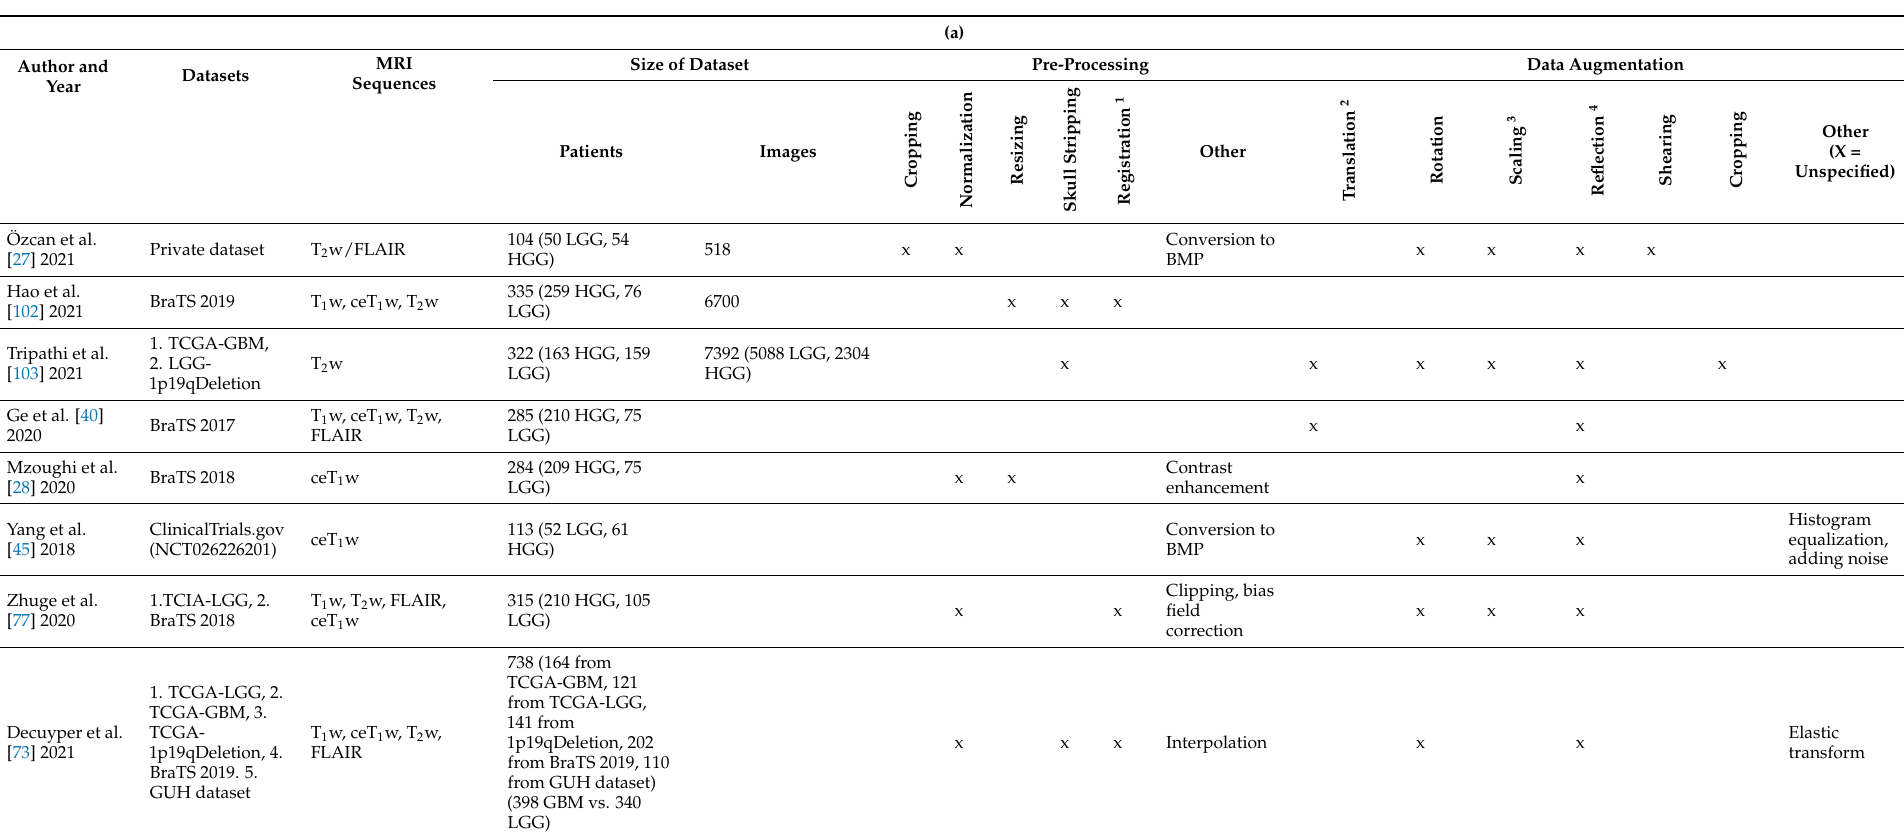
Table 4. (a) Overview of included studies that focus on CNN-based deep learning methods for brain tumor classification, with the exception of studies focusing on normal vs. tumorous classification. Datasets, MRI sequences, size of the datasets, and preprocessing methods are summarized. (b) Overview of included studies that focus on CNN-based deep learning methods for brain tumor classification, with the exception of study focusing on normal vs. tumorous classification. Classification tasks, classification architecture, validation methods, and performance metrics are